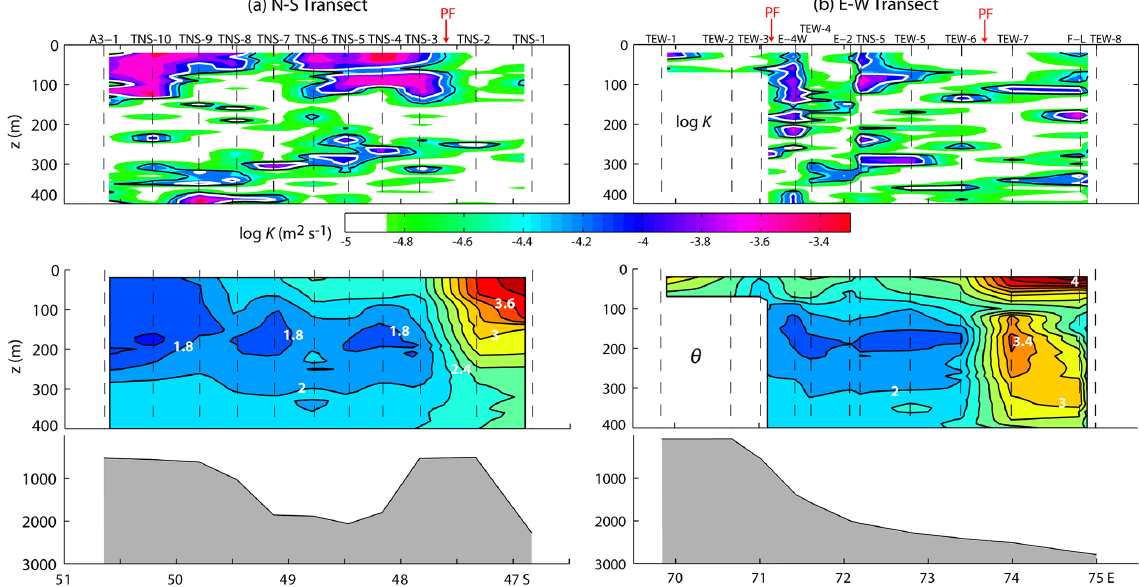
Figure 6. Thorpe-scale-derived diffusivity sections (calculated using the Shih parameterization and the R o = 0 . 25 criterion) of the upper 400m on (a) the N–S transect and (b) the E–W transect (top panels; see Fig. 1 for locations of the transects and stations). Diffusivity K values, which range from 1 × 10 − 5 to 7 × 10 − 4 m 2 s − 1 , are shown in log ( K ). White and black lines correspond to 1 × K = 10 − 4 m 2 s − 1 and K = 5 × 10 − 5 m 2 s − 1 , respectively, while the regions without color shading correspond to K <2 × 10 − 5 m 2 s − 1 . For ease of interpretation in combination with the 3-D frontal circulation of water masses (see also Fig. 1), corresponding temperature sections (middle panels) and seabed profiles drawn from in situ station depths measured during the KEOPS2 cruise (bottom panels) are also shown.